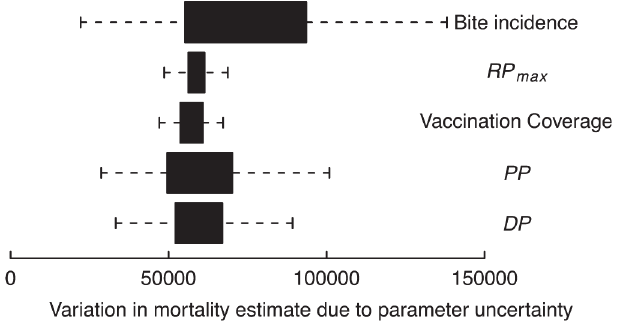
Fig 4. Model sensitivity to parameter uncertainty. PEP = post-exposure prophylaxis.